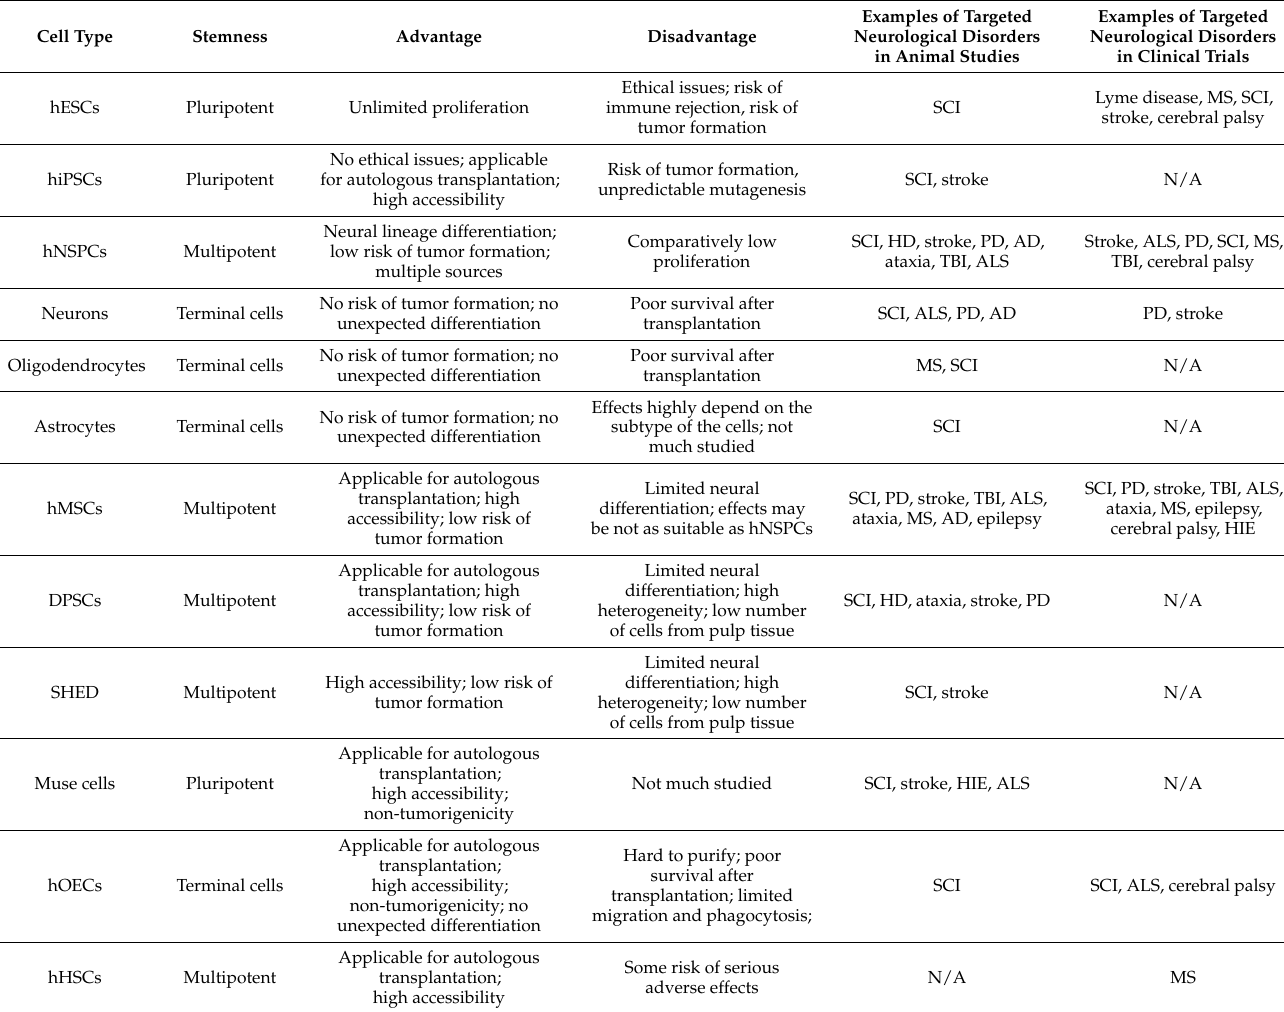
Table 7. Characteristics of cell candidates for neurological disorders through direct